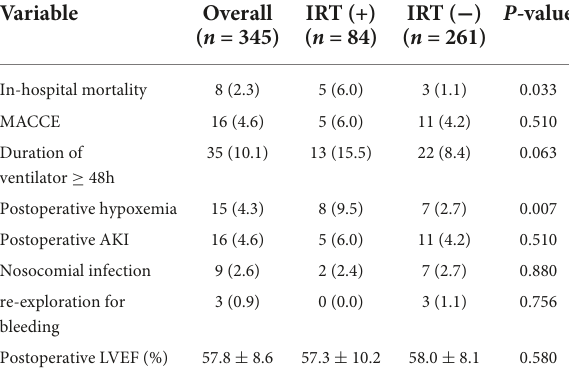
TABLE 3 In-hospital clinical outcomes of the groups.